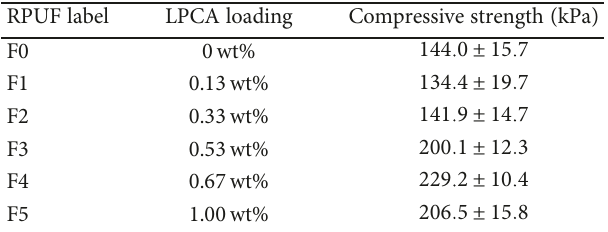
Figure 1: The macrophoto of RPUFs. Table 4: E ff ect of LPCAs on the expansion ratio and the compressive strength of RPUFs.